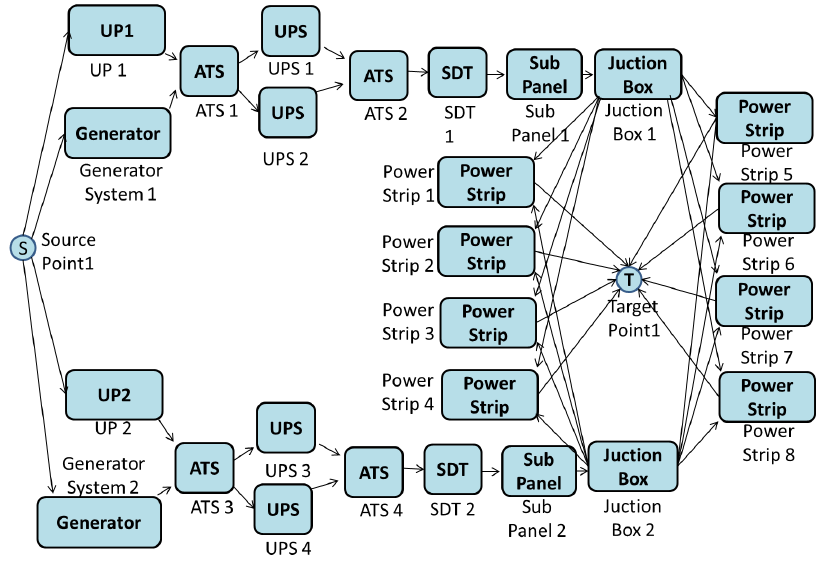
Figure 20. EFM model of Tier